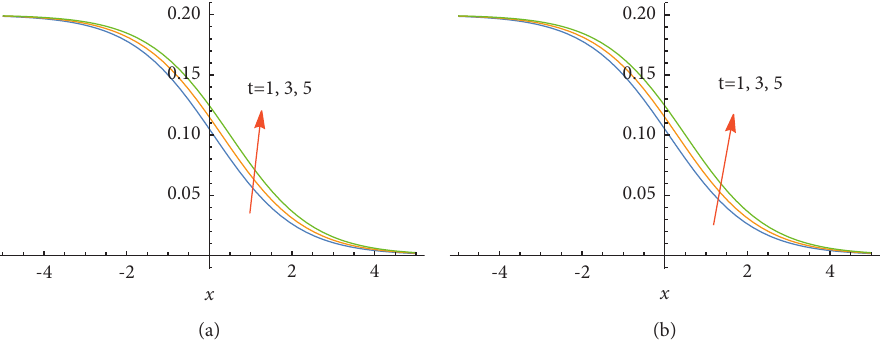
Figure 2: The exact solution (a) and the approximate solution (b) by the sinc method for different values of time t and − 5 ≤ x ≤ 5 for Example 1.